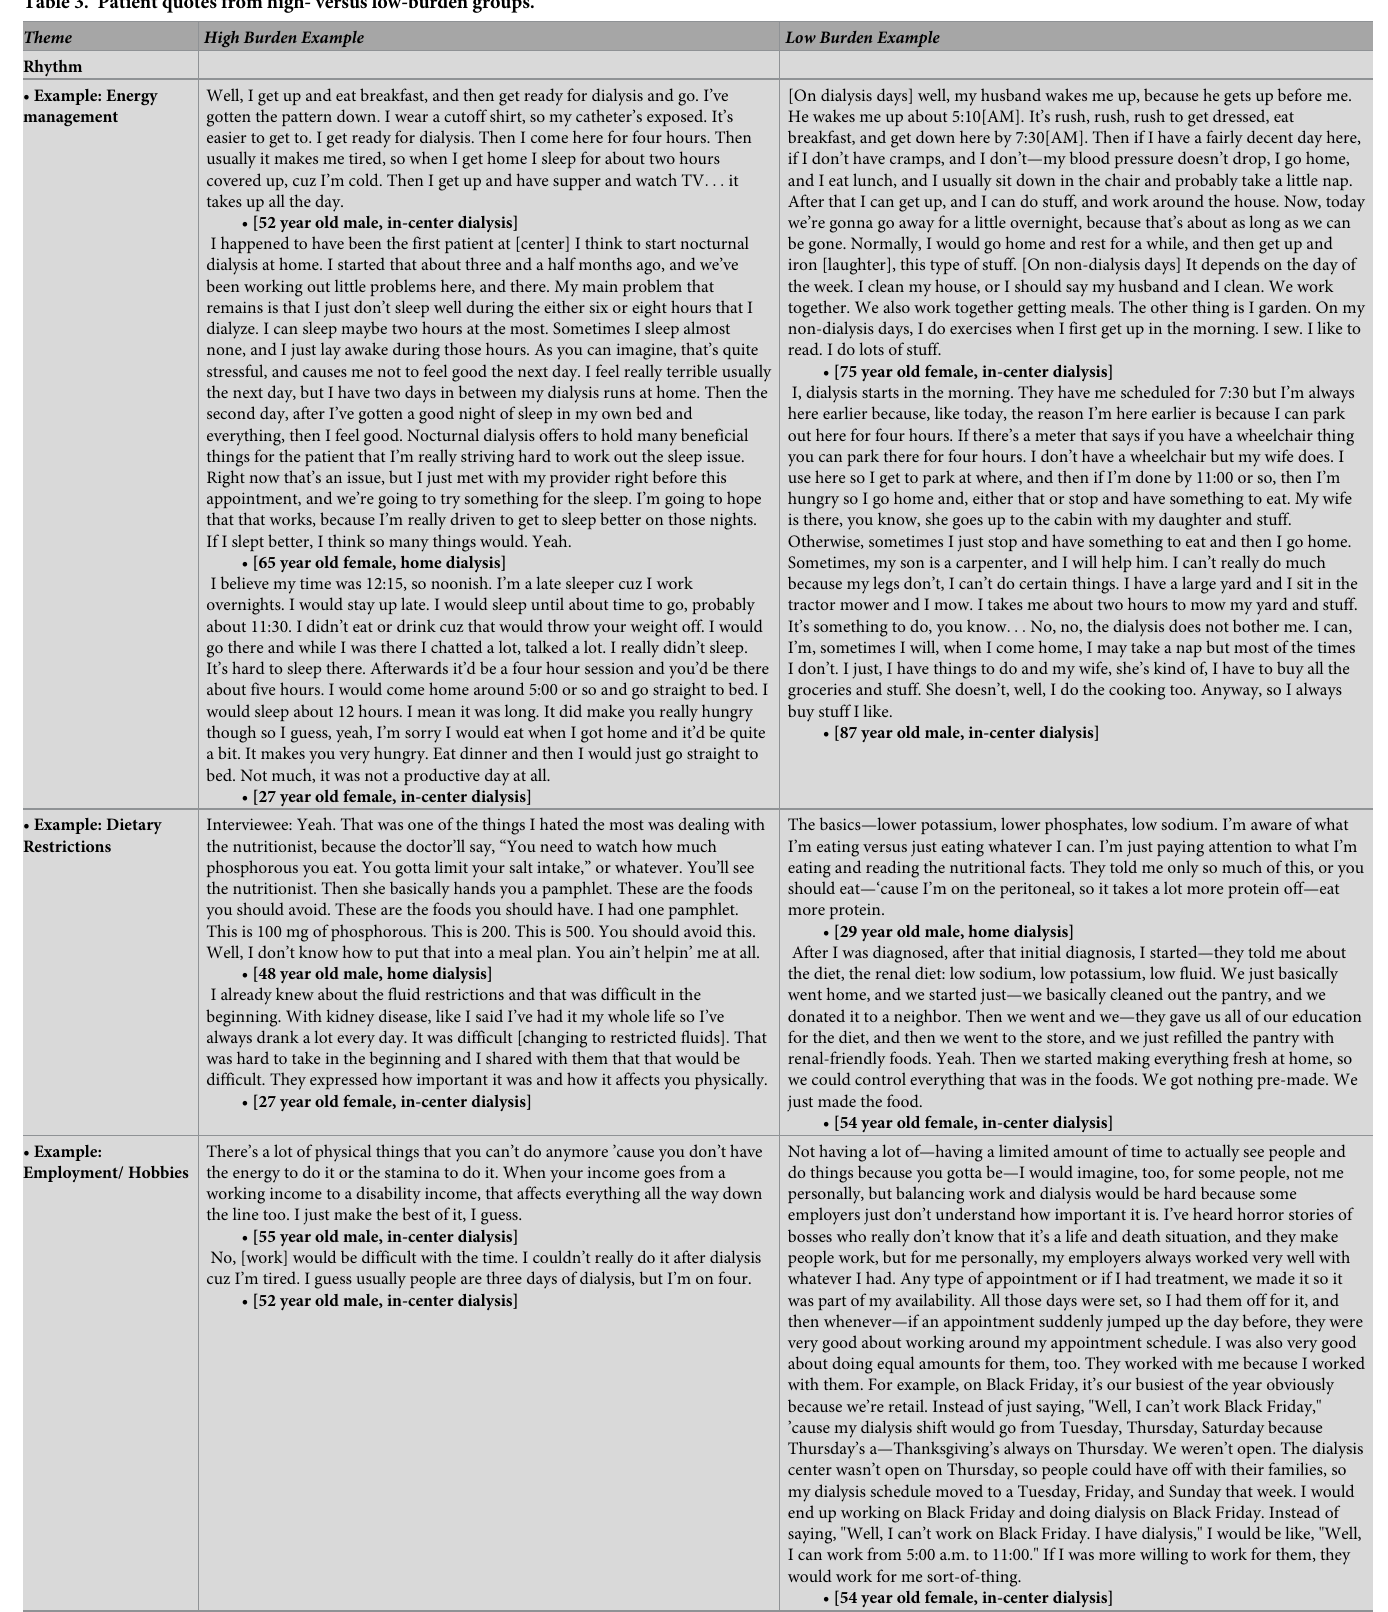
Table 3. Patient quotes from high- versus low-burden